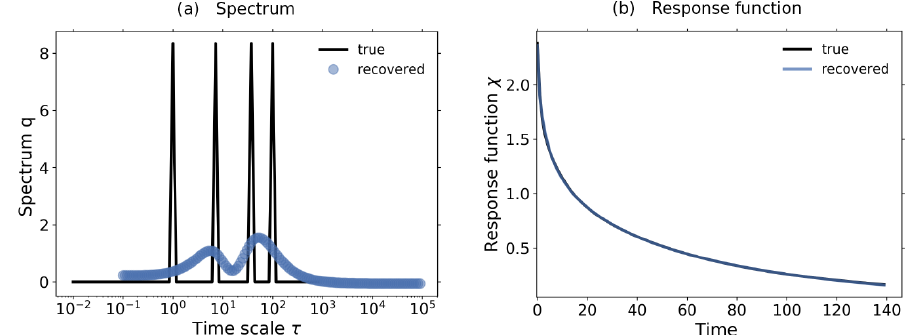
Figure E6. Spectrum q λ and response function χ(t) recovered from a 1% experiment performed with the toy model described in Part 1 taking an underlying discrete spectrum with four timescales τ = 1, τ = 7, τ = 37, and τ = 100. The data were taken with SNR ∼ O ( 10 4 ) − O ( 10 5 ) .